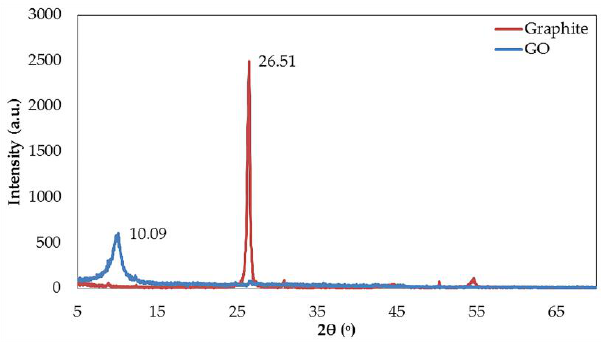
Figure 1. The powder X-ray diffraction (XRD) patterns of graphite and GO.